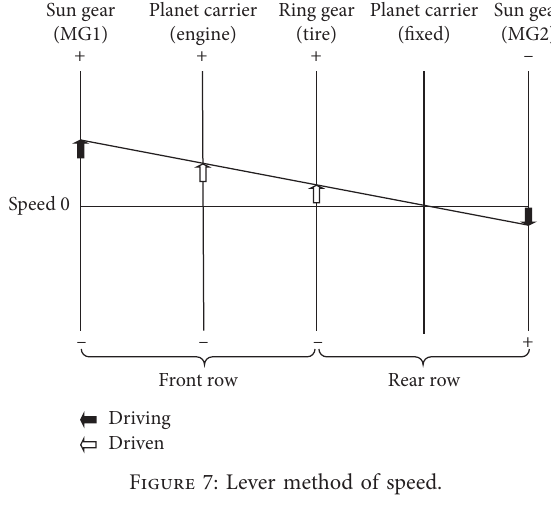
Figure 7: Lever method of speed.